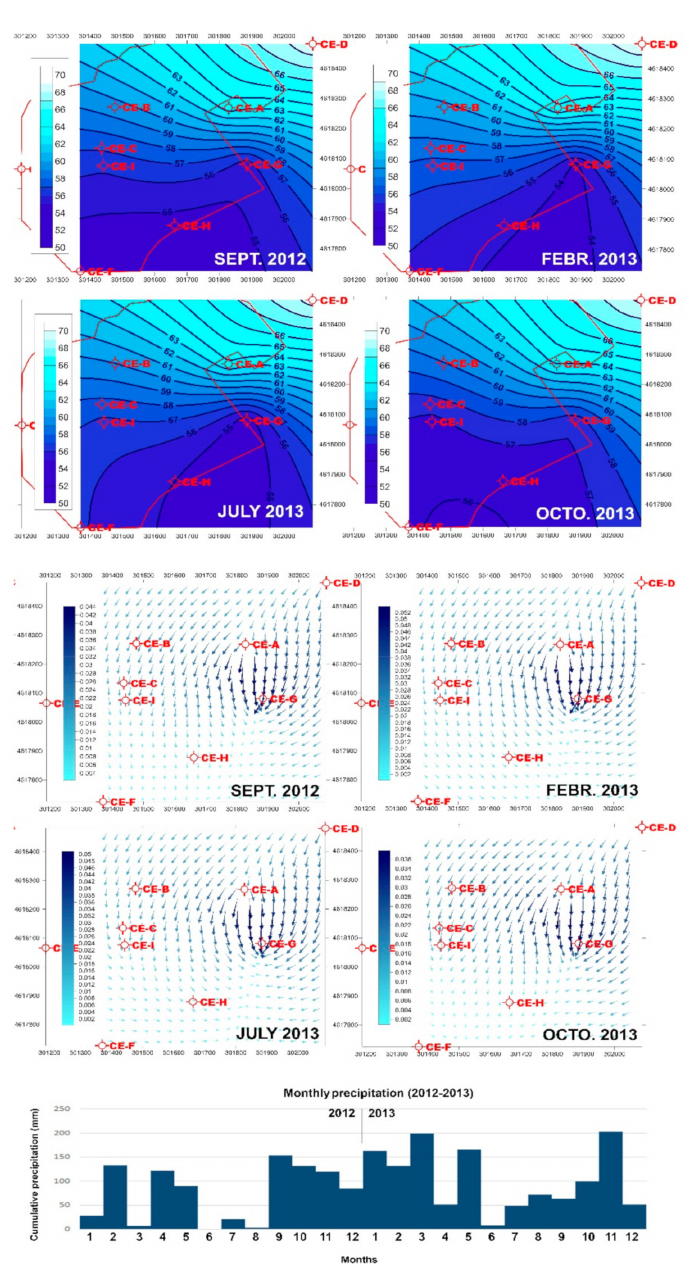
Figure 4. Reconstruction of the piezometric level variations (meters above sea level) in the di ff erent sampling campaigns: I September 2012; II February 2013; III July 2013; IV October 2013. Each red circle represents a piezometer sampled (CE-A, CE-B, CE-C, CE-D, CE-F, CE-G, CE-H, and CE-I). The blue arrows show the drainage direction and magnitude. The red line corresponds to the contour of the waste treatment plant. In the bottom part of the Figure, the monthly cumulative precipitation are